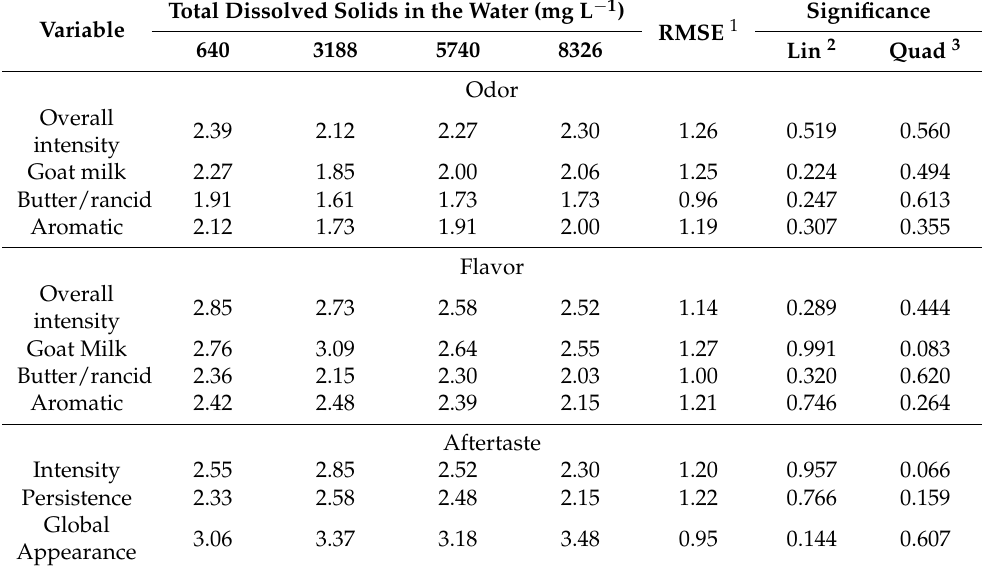
Table 6. Mean scores of the quantitative descriptive analysis of the milk of goats of the Alpine breed subjected to treatments with increasing levels of total dissolved solids over a period of 48 days of exposure.